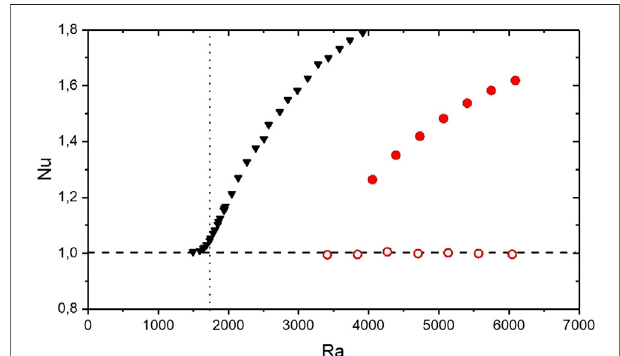
FIGURE 1 | Stability diagram. Nusselt number as a function of Rayleigh number for a single component fl uid (liquid Helium, triangles) and LUDOX TM colloidal silica nanoparticles in water at a concentration of 4.0% w/w (circles). The colloidal sample exhibitsbistability,represented bytheco-existence of a stable convective branch (full circles) and a stable conductive branch (open circles). The dashed horizontal line represents the purely conductive regime (Nu = 1), while the vertical dotted line is the threshold Ra c = 1708 for Rayleigh-Bénard convection in a single component fl uid. Transient rotating structures are observed in the range of Rayleigh numbers 2000 < Ra <